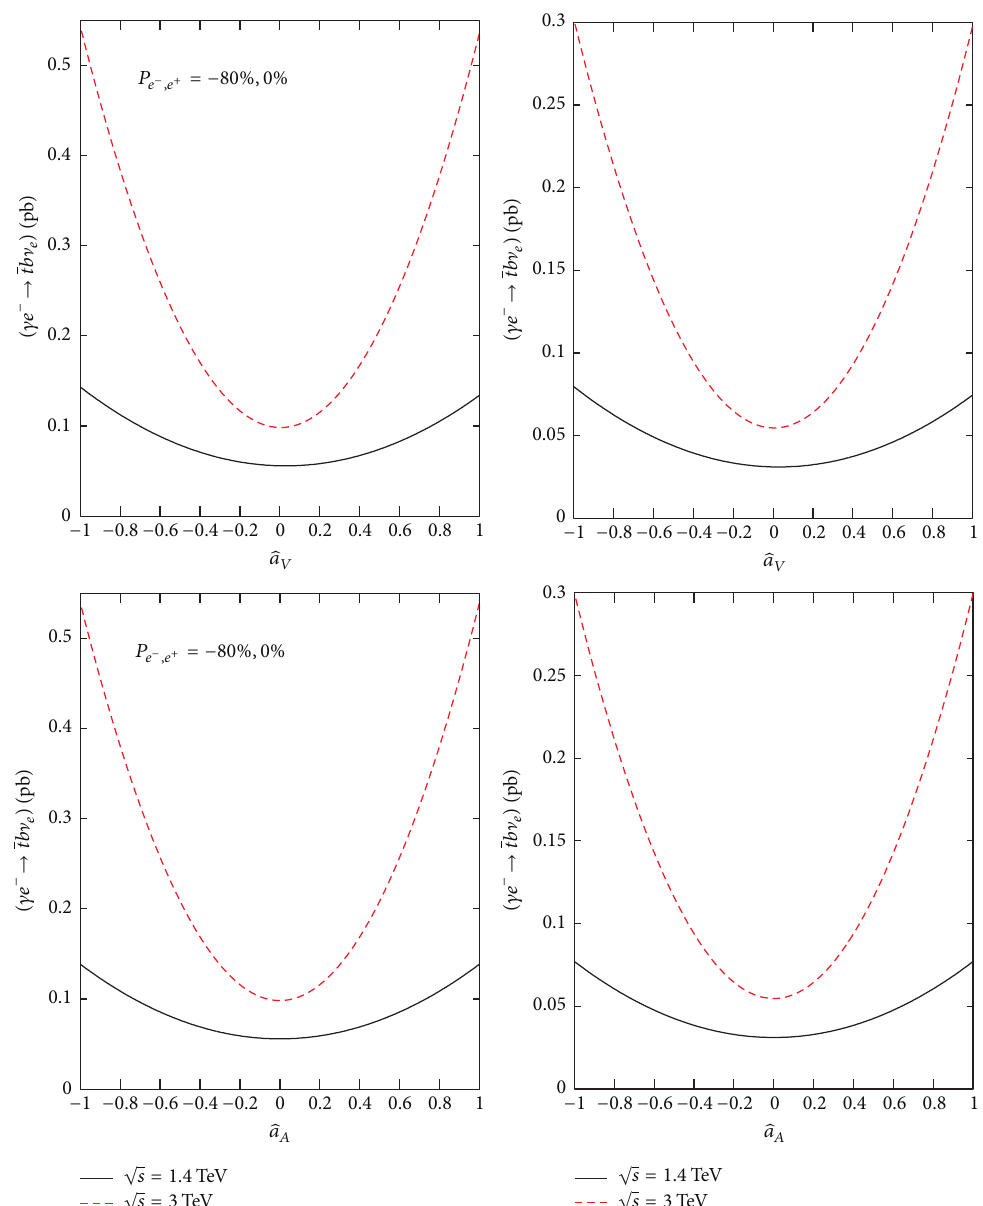
Figure 3: The integrated total cross section of the process 𝛾𝑒 − → 𝑡𝑏 ] 𝑒 ( 𝛾 is the Compton backscattering photon) as a function of ̂𝑎 𝑉 and ̂𝑎 𝐴 with √𝑠 = 1.4, 3 TeV and polarized and unpolarized